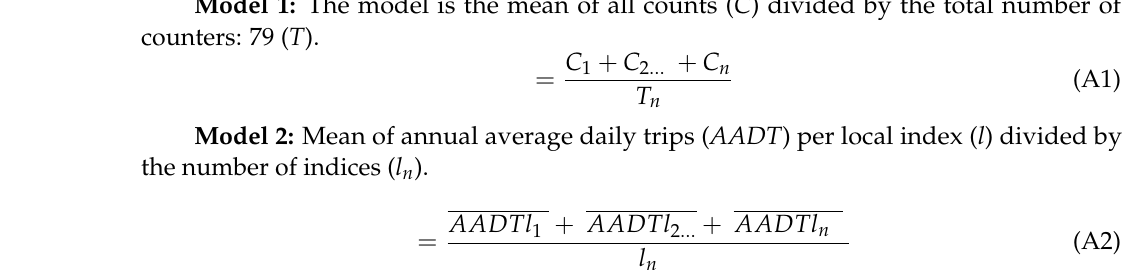
Model 2: Mean of annual average daily trips ( AADT ) per local index ( l ) divided by the number of indices ( l n ).